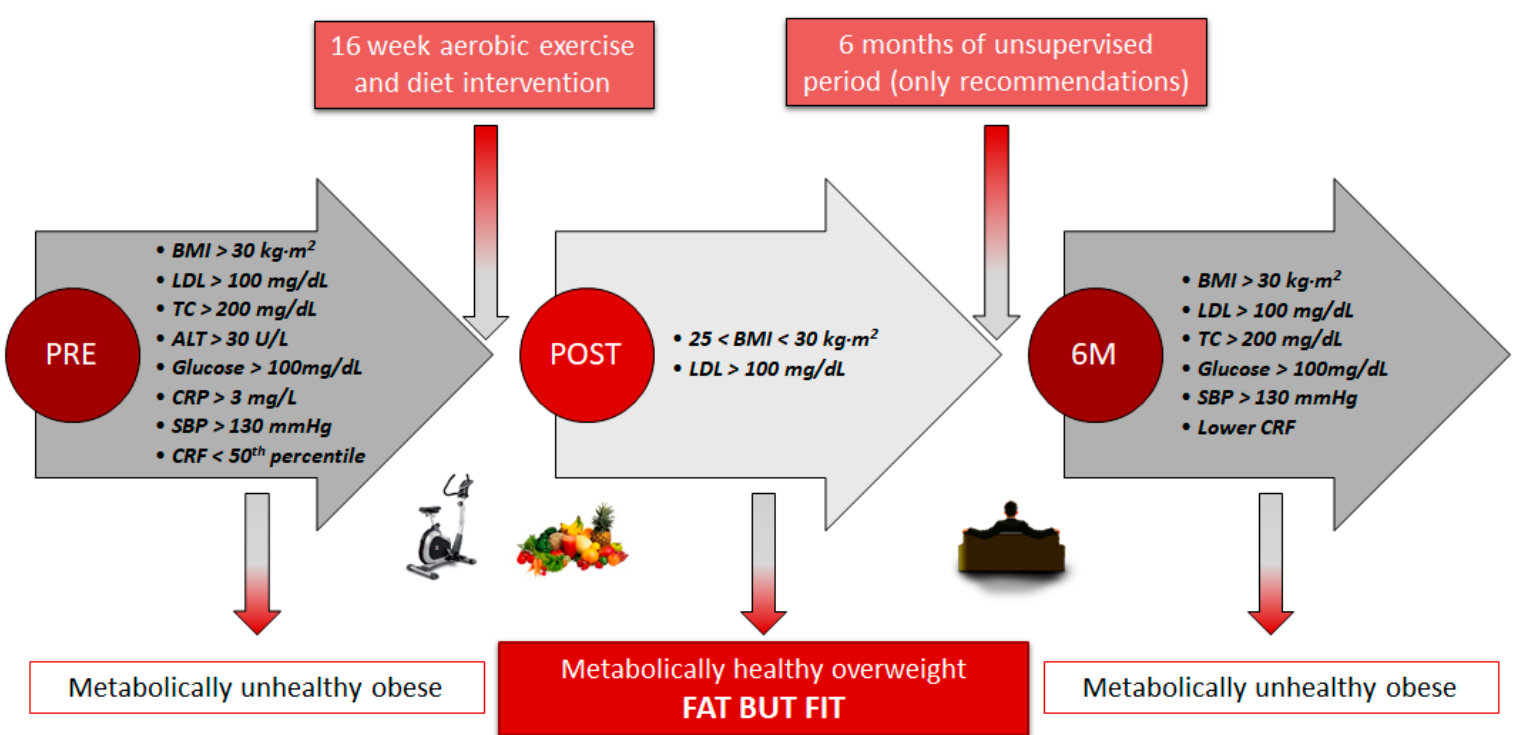
Figure 2. Participants’ profile from metabolically unhealthy obese to metabolically healthy overweight and back. BMI: Body mass index. LDL: Low-density lipoprotein cholesterol. TC: Total cholesterol. ALT: Alanine aminotransferase. CRP: C-reactive protein. SBP: Systolic blood pressure. CRF: Cardiorespiratory fitness.